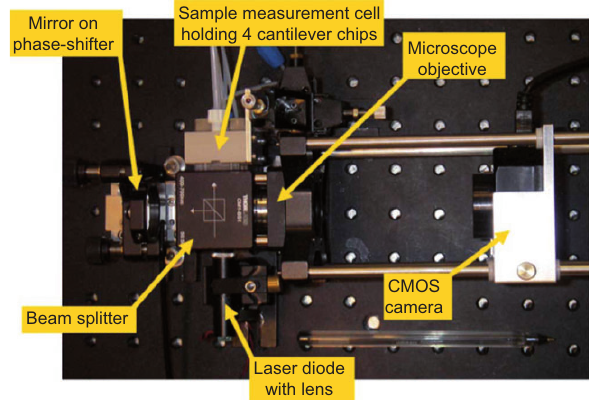
Figure 3 Prototype bread-board system of a PSIM instrument for the simultaneous monitoring of the displacements of multiple MCAs. Reproduced with permission from Kelling et al. (2009) .